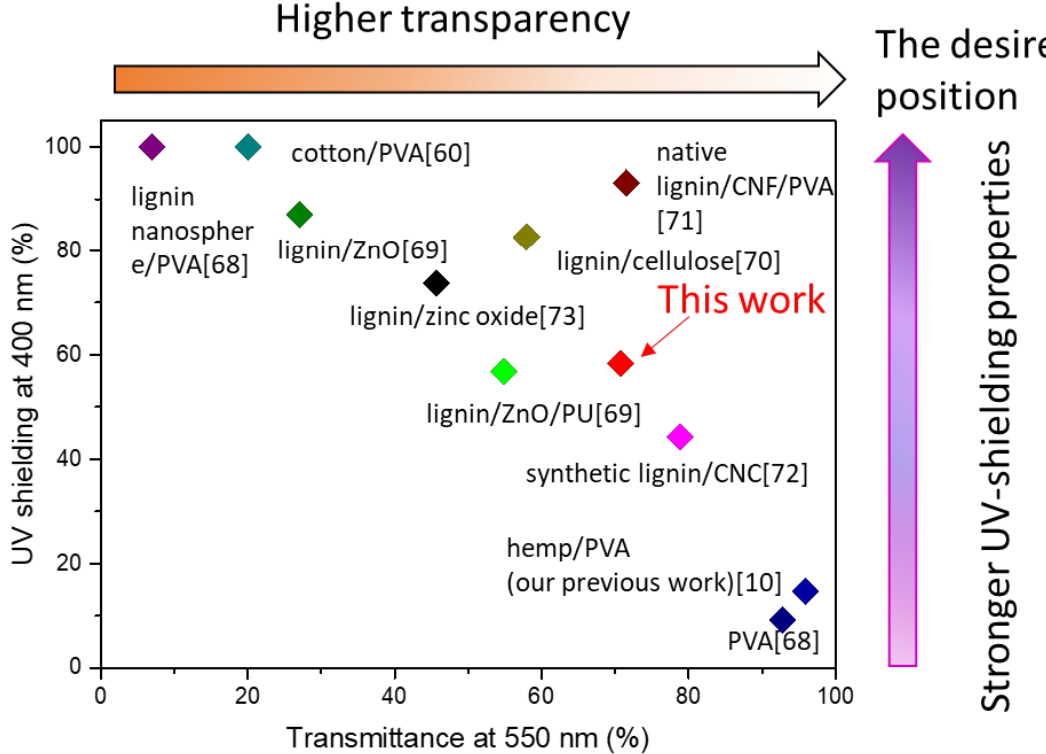
Figure 8. The UV-shielding properties of lignin-CNCs7 20 wt. % film developed in this study in comparison with other lignin UV-shielding composites (this figure was adapted from our previous review paper [66], with the data from reference [10,60,68 – 73]).